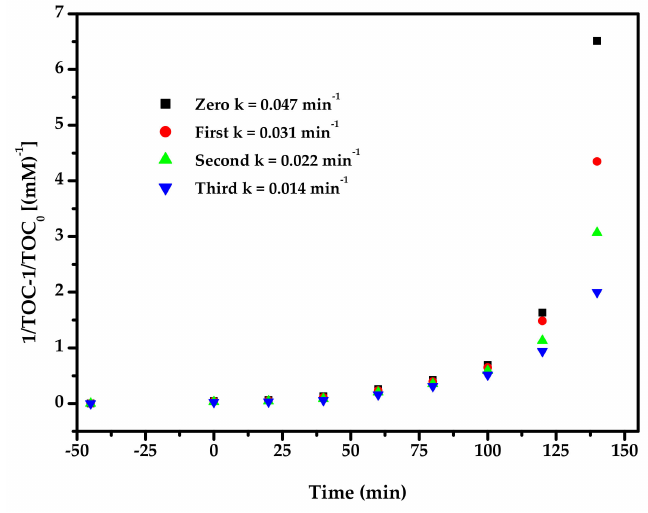
Figure 18. Observed second-order kinetic plots for TOC during the PD of DO with Bi 2 SmSbO 7 /ZnBiYO 4 heterojunction as the photocatalyst under VLI for 3 cyclical degradation